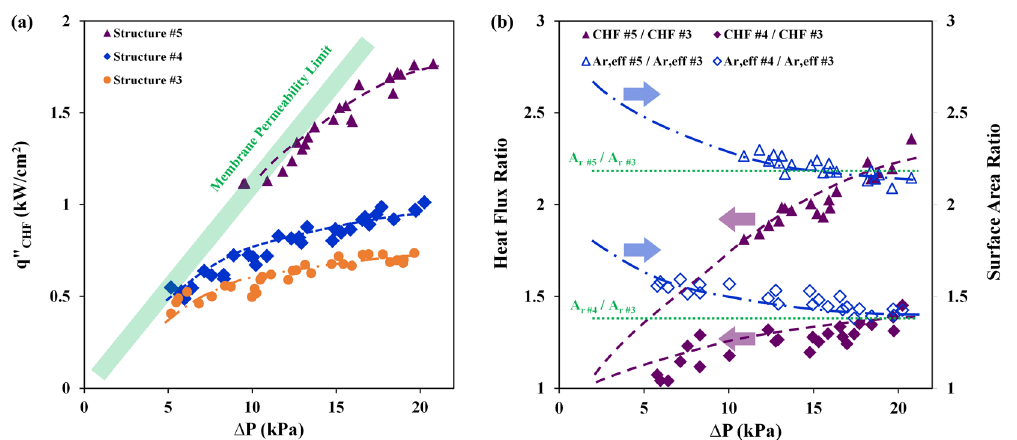
Figure 6. Effect of enhanced heat transfer area; ( a ) CHF as a function of applied liquid pressure and ( b ) CHF ratios of different structures as a function of pressure and comparison with enhanced area ratios of the corresponding structures (the experimental values are linearly extrapolated to estimate values at lower